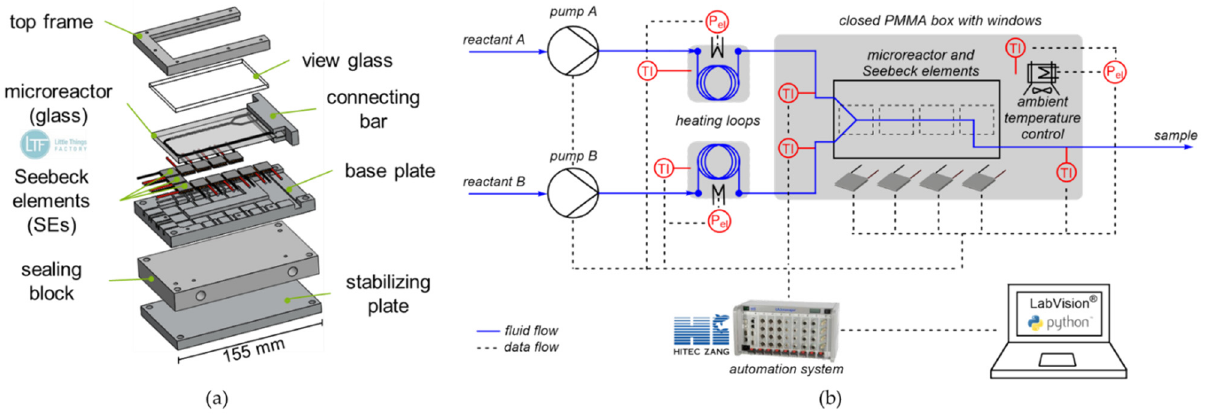
Figure 1. ( a ) Exploded view of the microcalorimeter; ( b ) Experimental setup used for calorimetric measurements.